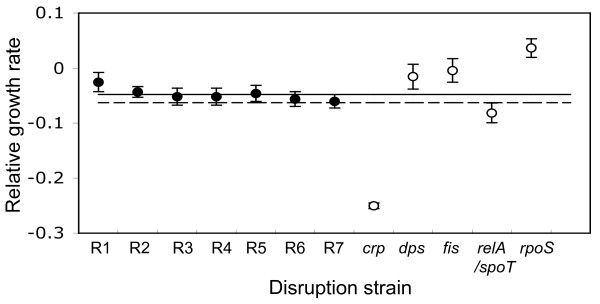
Effect of random and hub mutations on growth in the reference environment. The effect of each disruption was measured as the log ratio of the growth rate of the disruption strain to that of the reference strain. Random disruption strains, solid symbols; Targeted hub disruption strains, hollow symbols. Error bars indicate 95% confidence intervals. Solid line indicates mean of random disruption strains; dotted line indicates mean of targeted hub disruption strains.